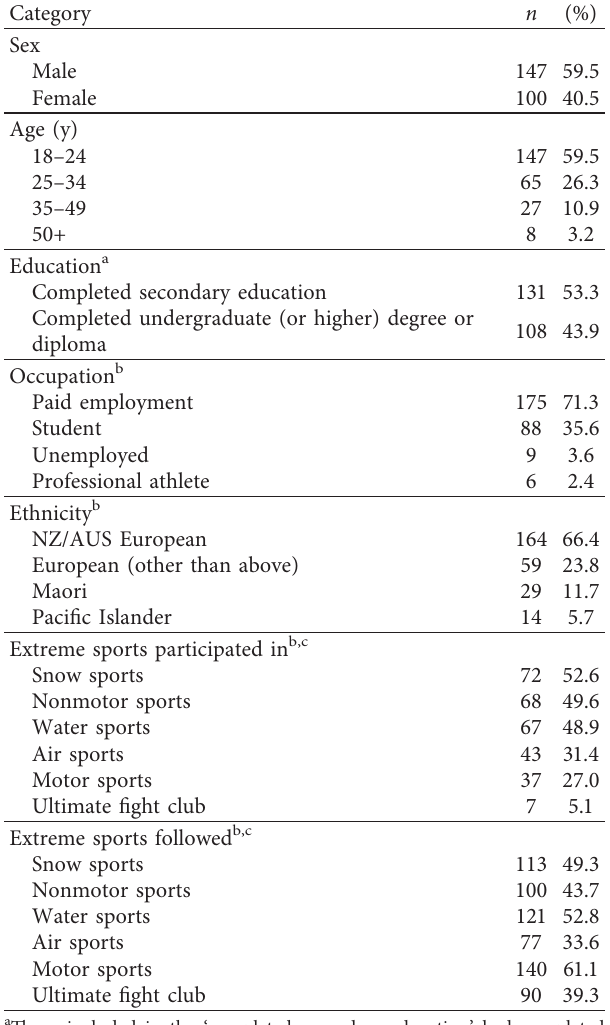
Table 1: Demographics of those completing the questionnaire on energy drink consumption.